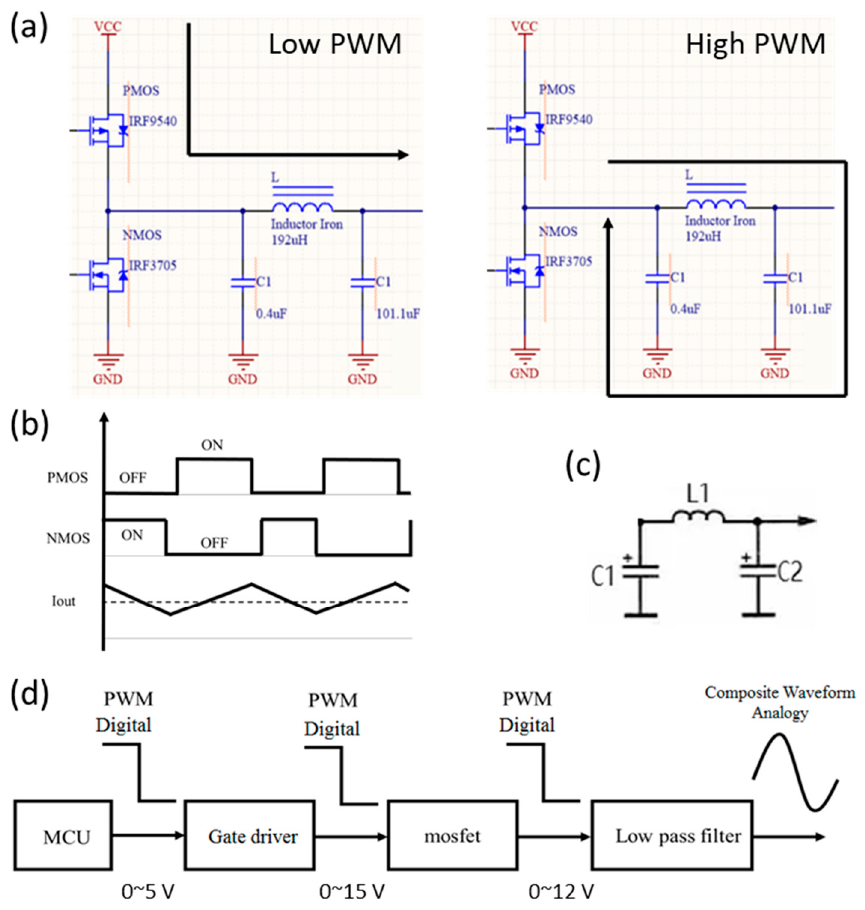
Figure 3. ( a ) Pulse width modulation (PWM) state; ( b ) Working sequence diagram; ( c ) π type filter; ( d ) Signal conversion between components.